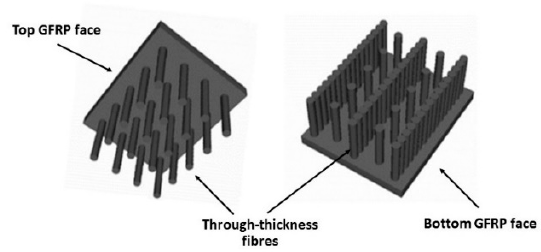
Figure 14. Schematic representation of PU foam ‐ filled honeycomb core composite panel. Adapted from [57].